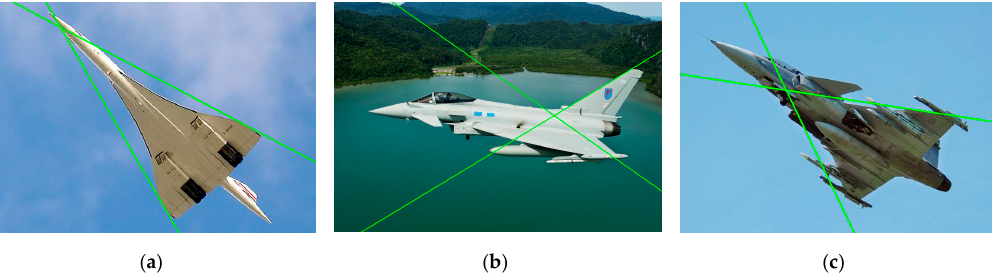
Figure 9. Incorrect results of the extraction of wing leading edge lines: ( a ) the leading edge of the wing is not a straight line; ( b ) portions of the wings are not visible in aircraft images from some viewpoints; ( c ) some parts of the aircraft affect the line detection.